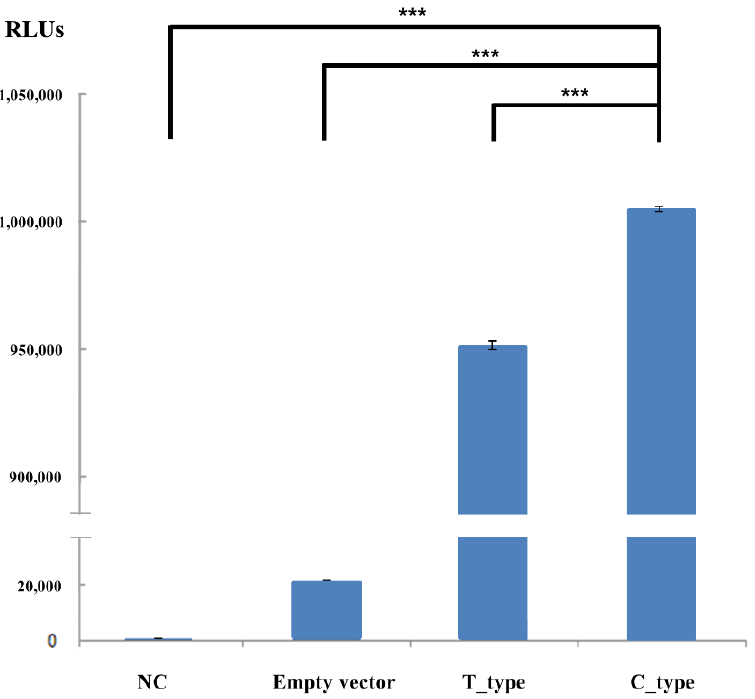
Figure 3. Promoter activity of the bovine IFITM3 gene. Promoter activities of the bovine IFITM3 gene with 2 promoter types. The symbol “***”, indicates p < 0.001. RLUs indicate relative luciferase light units. NC indicates negative control. Table 7. In silico annotations of polymorphism of the bovine IFITM3 gene.